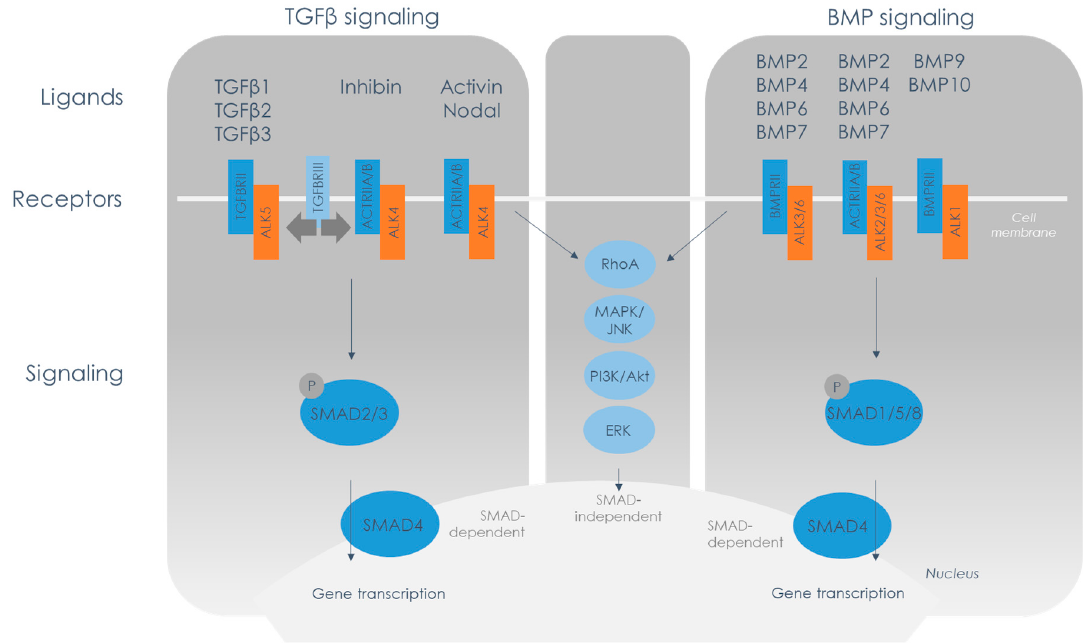
Figure 1. Schematic overview of TGF β family signaling. TGF β family signaling can be divided into two clusters: TGF β - (left) and BMP- (right) signaling. TGF β 1, -2 and -3 bind the TGF β receptor II and activate signaling via type I receptor ALK5. Activin, nodal and inhibin can bind to the activin receptor IIA or IIB and propagate signaling via ALK4. Signaling via ALK4 and ALK5 leads to phosphorylation of SMAD2 / 3. Upon binding to SMAD4, this SMAD complex translocates to the nucleus to initiate gene transcription. Of note is that ALK7 (not displayed) can also initiate signaling via SMAD2 / 3, but this type I receptor is assumed to be unimportant in epicardial behavior. On the BMP side, BMPs can bind to either the activin receptor IIA or IIB, or to the BMP type II receptor, that can activate the signaling cascade via ALK2, -3 or -6, or via ALK1. Signaling via ALK1 / 2 / 3 / 6 results in phosphorylation of SMAD1 / 5 / 8 which, after binding to SMAD4, translocates to the nucleus and starts gene transcription. Besides the described SMAD-dependent pathways, both TGF β and BMP pathways can activate SMAD-independent pathways, shown in the middle panel.